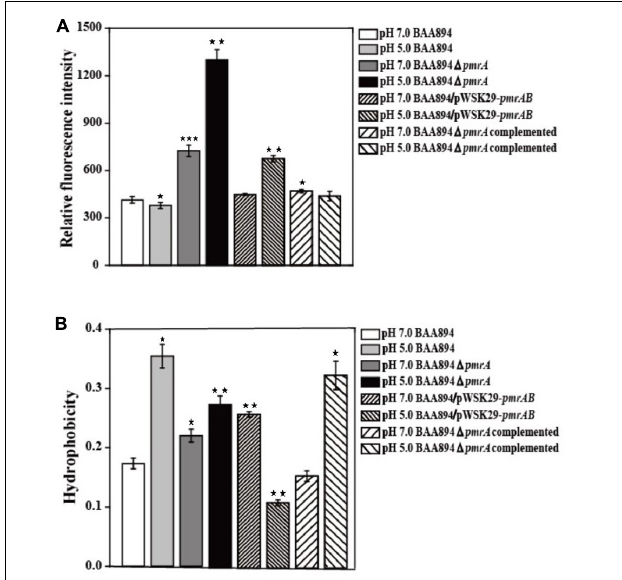
FIGURE 2 | The cell surface properties of mutants derived from BAA894 cultured in pH 7.0 and pH 5.0. (A) Membrane permeability assay. (B) Hydrophobicity assay. The values represent the mean ± SD of results from three independent experiments. The data were analyzed by one-way analysis of variance. Statistically significant differences between the mutants in pH 7.0 and pH 5.0 and wild strains BAA894 in pH 7.0: * p < 0.05; ** p < 0.01; and *** p < 0.001.